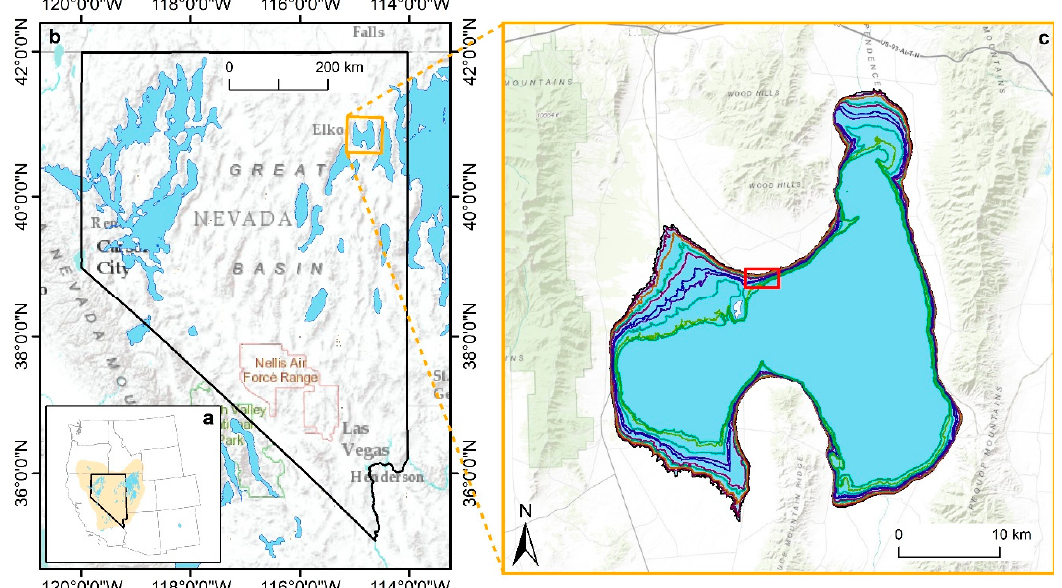
Figure 1. ( a ) Inset map showing the state of Nevada (bold outline) in the western US. The beige polygon delineates the hydrographic Great Basin, and blue polygons represent pluvial lakes [4]; ( b ) Enlarged view of Nevada and pluvial lakes during the late Pleistocene. Orange square highlights Lake Clover and the area of panel c; ( c ) Enlargement of the Clover and Independence Valleys that hosted Lake Clover. The extent of the lake at its highstand is shown in blue; mapped shorelines at lower elevations are shown as lines. The red box highlights the study area shown in Figure